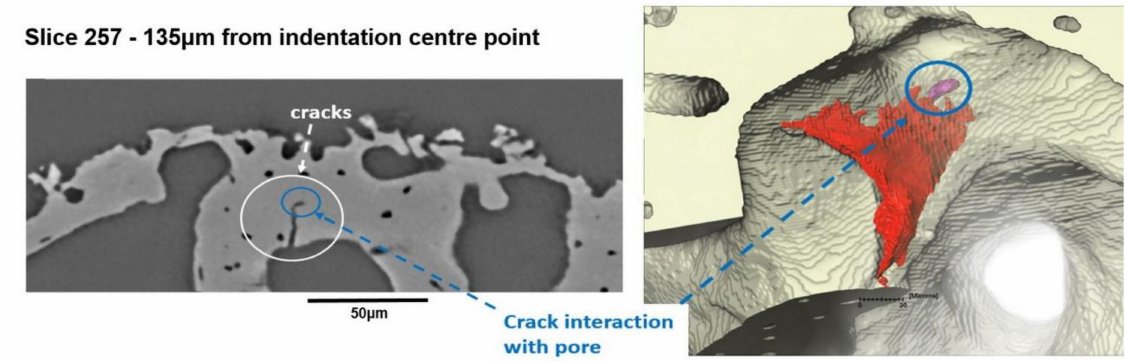
Figure 10. 2D and 3D visualisations of a larger flexural crack from the opposite side of the indenter tip showing how the 2D image can be misleading in terms of crack complexity and